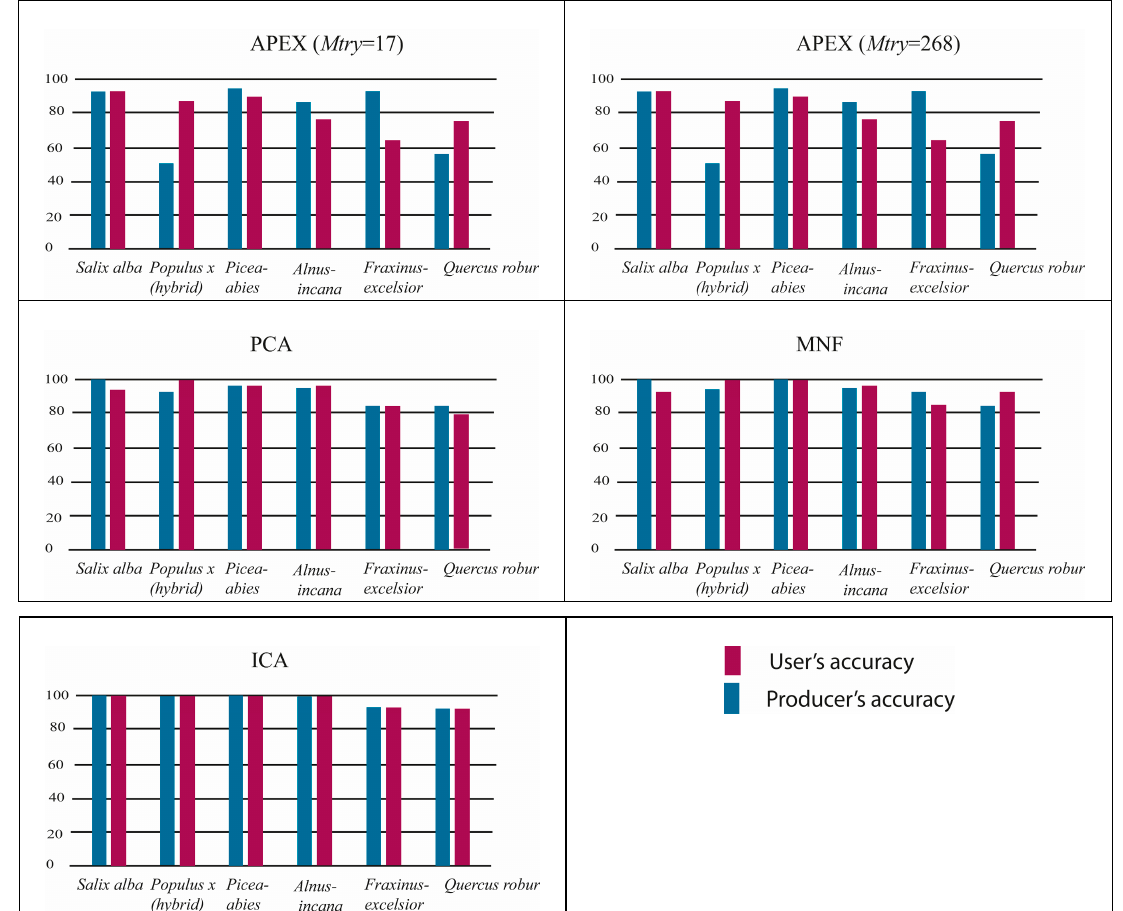
Figure 10. Performance of each class (producer’s and user’s accuracies).